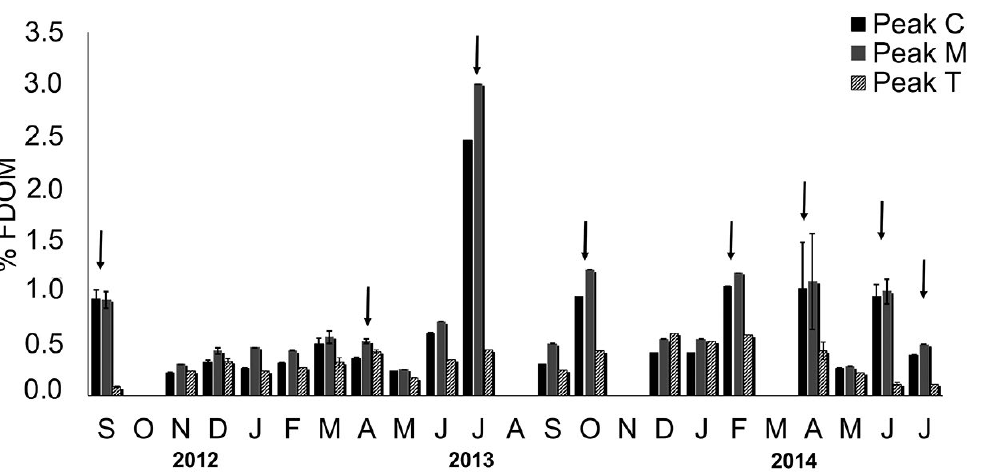
Fig. 1. – Daily aerosol deposition-derived FDOM flow to the sea surface as a percentage of concentration in Barcelona coastal waters. Humic- like (peak C and peak M) and protein-like (peak T) substances. The arrows indicate the Saharan dust events. The percentages were calculated as the daily average of the deposition considering five different time frames (one to five days).